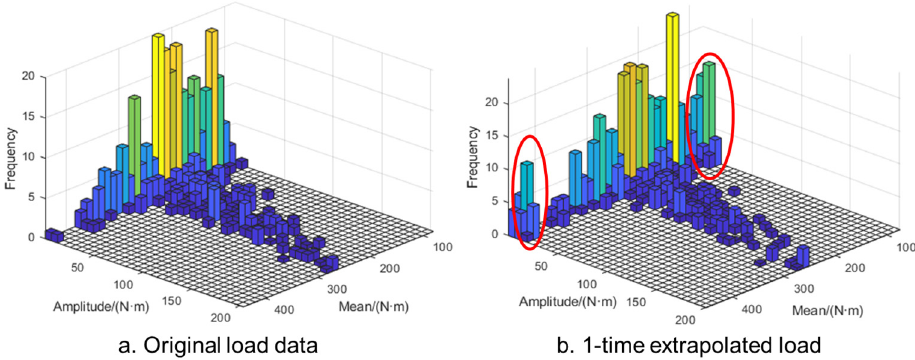
Figure 8. Comparison of rain flow matrixes: ( a ) original load; ( b ) 1-time extrapolated